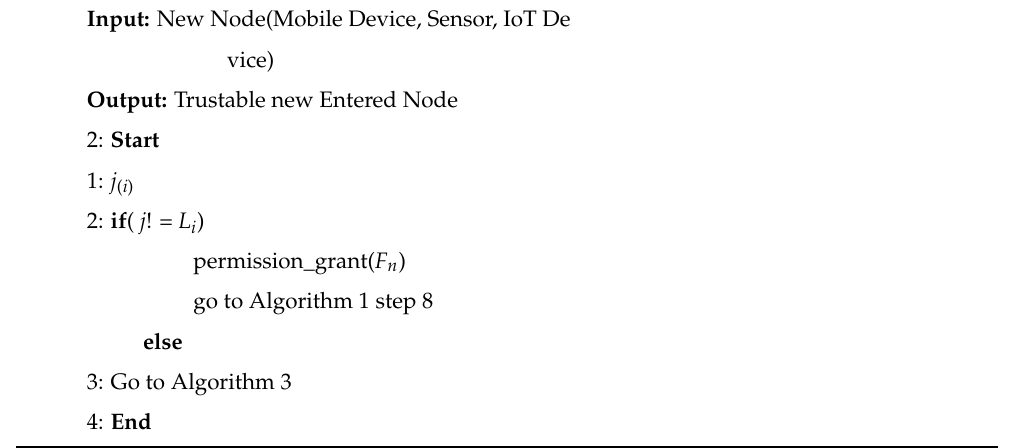
Algorithm 2. New